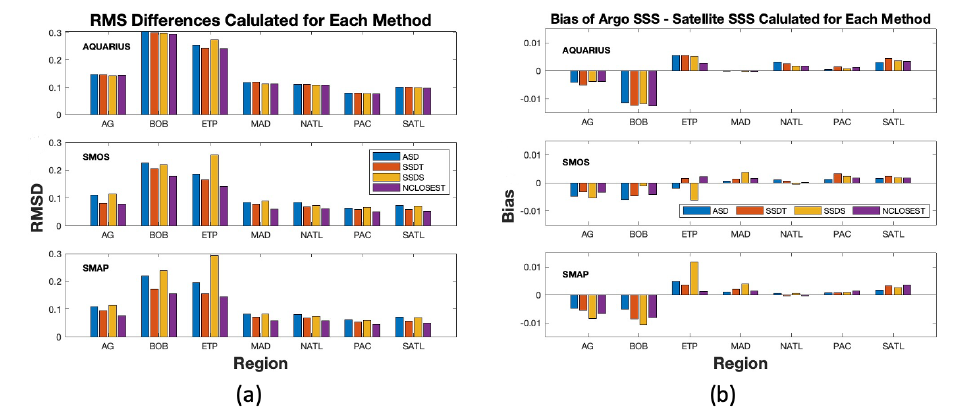
Figure 6. Statistics describing the differences produced by each of the four matchup methods tested in every region using Aquarius, SMAP, and SMOS simulated data. Different colored bars are for different methods and groupings of bars are for different regions as indicated in the legend of each panel. ( a ) RMSD. ( b ) Bias. (difference = Argo SSS − Satellite SSS). A similar figure showing the standard deviation of errors can be found in the Supplementary Information (Figure S3).